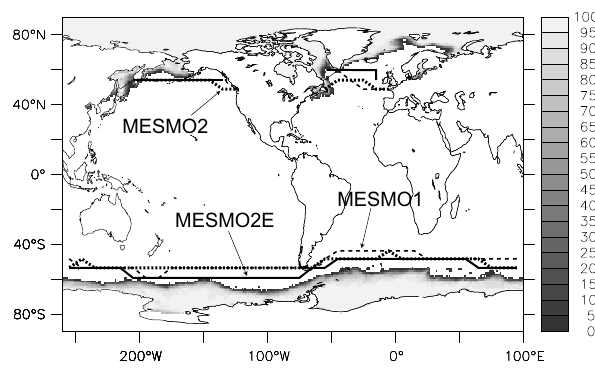
Fig. 6. Observed and model-simulated maximum seasonal sea ice extent. Observations indicated in greyscale are based on satellite- based passive microwave data (1/1987–12/1988) archived at the Na- tional Snow and Ice Data Center (A. Nomura and R. Grumbine, personal communication,